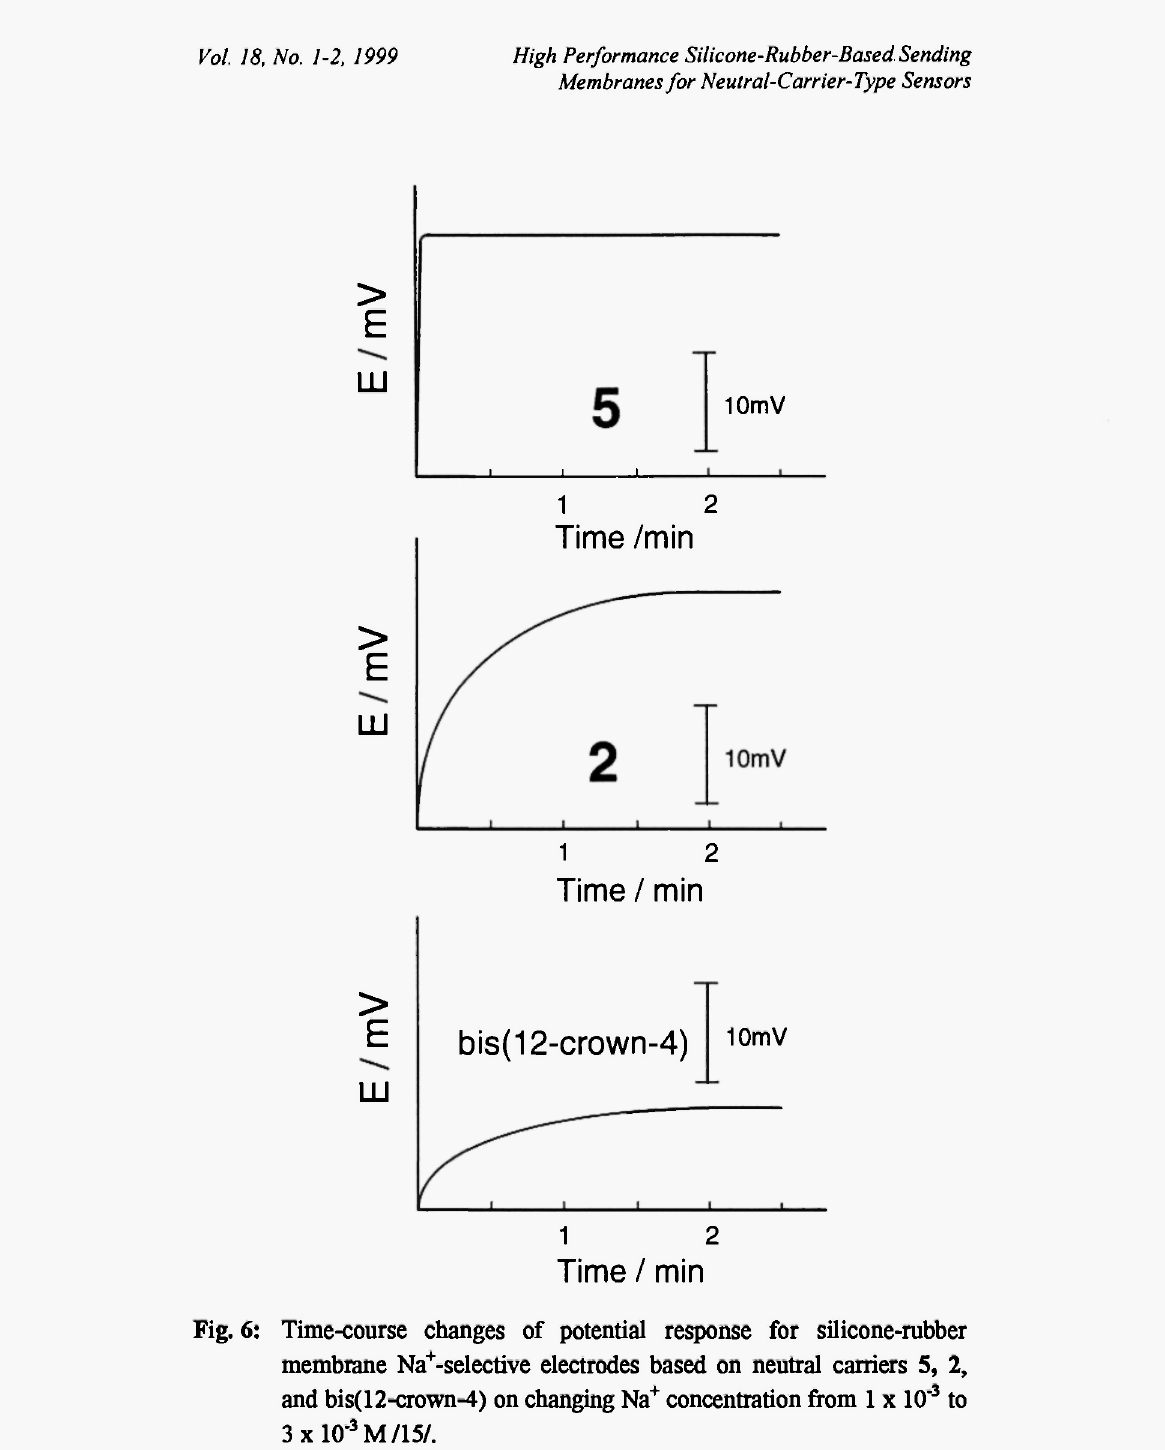
Fig. 6: Time-course changes of potential response for silicone-rubber membrane Na + -selective electrodes based on neutral carriers 5, 2, and bis(12-crown-4) on changing Na + concentration from 1 χ 10" 3 to 3 χ 10' 3